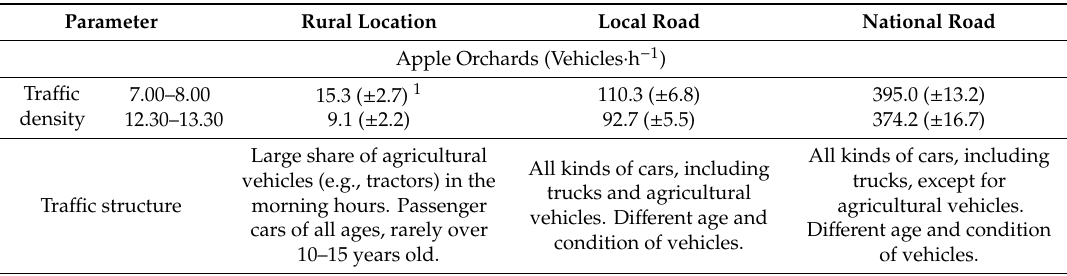
Table 1. Tra ffi c intensity and structure on the roads closest to the apple orchards. Data are means ± SE, n = 3.